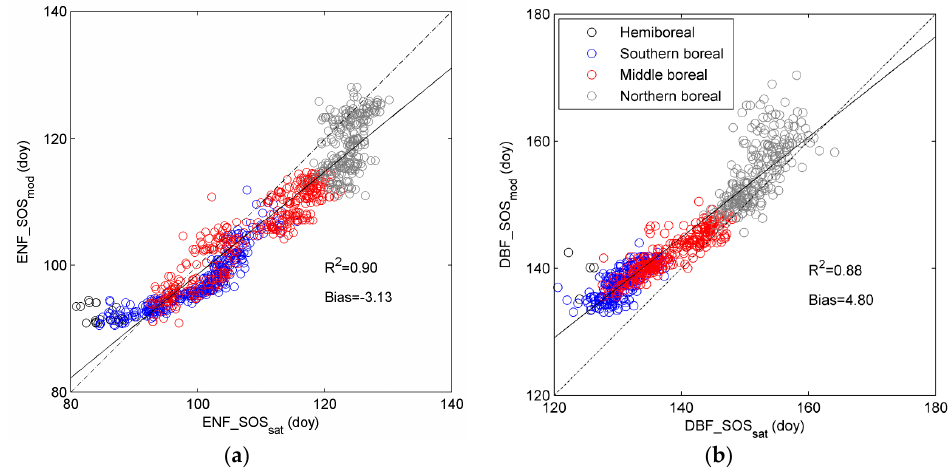
Figure 7. Scatterplots of mean satellite- and JSBACH model-derived start of season for forested areas in Finland for the period 2003–2010 for: ( a ) evergreen needle-leaf forest (ENF_SOS); and ( b ) deciduous broad-leaf forest (DBF_SOS). The dotted line gives the 1:1 line and the black line the linear fit between JSBACH-modelled and satellite-observed dates.